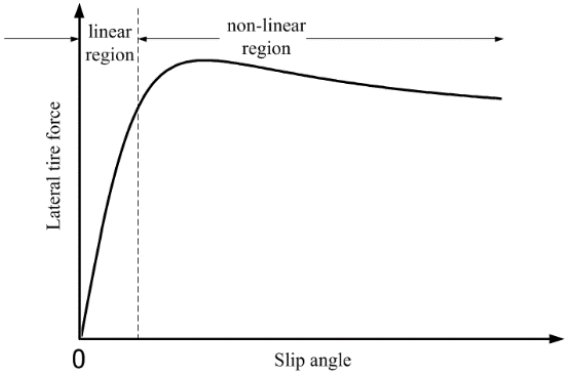
Figure 3. The lateral tire force and the slip